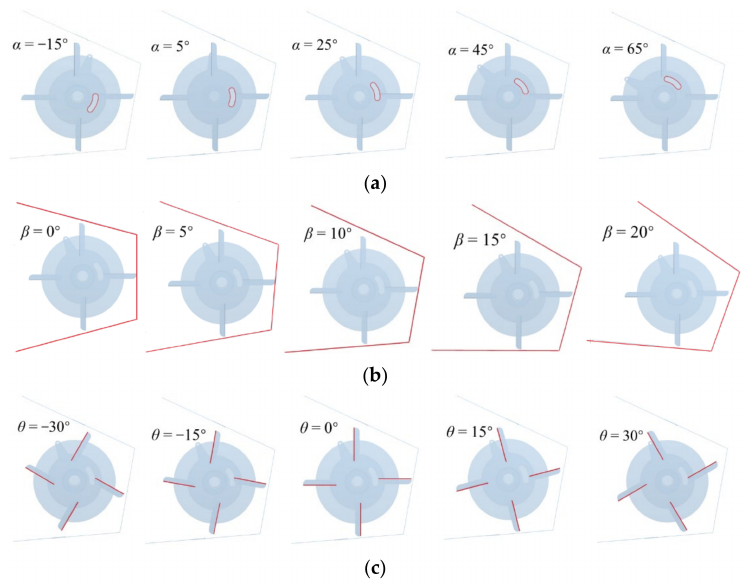
Figure 8. The structural changes of centrifugal disc spreader. ( a ) Feed gate hold position angle α ; ( b ) shield angle β ; ( c ) vane pitch angle θ